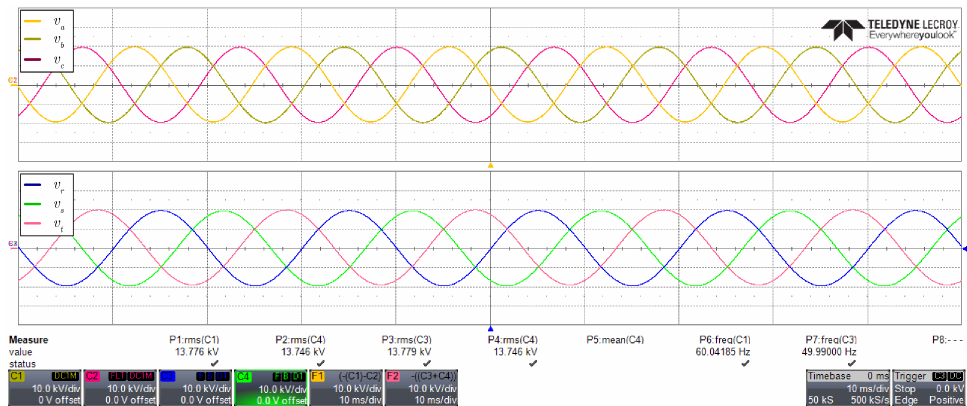
Figure 7. Hexverter line voltages in both ports, where the 13.8 kV rms value is measured in both ports, with a frequency of 60 Hz in port 1 and 50 Hz in port 2.